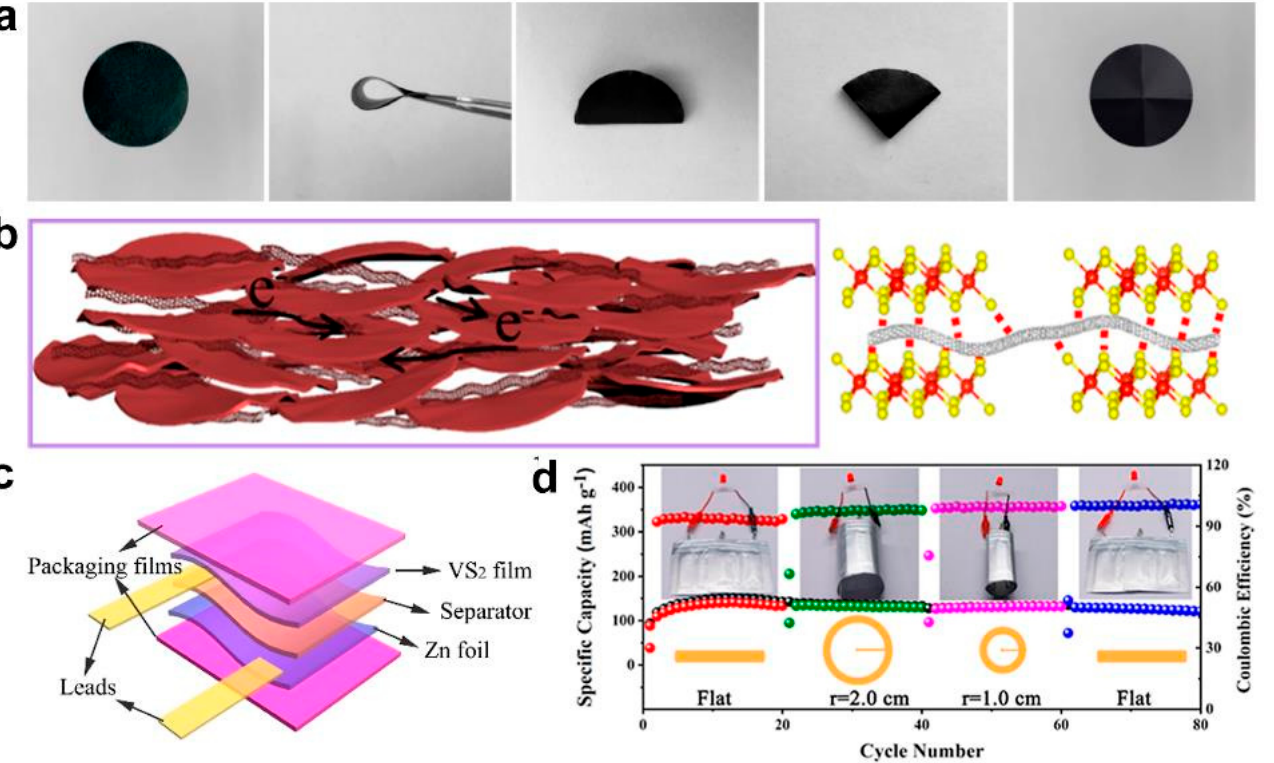
Figure 4. ( a ) Optical images of the flexible C-VS 2 film [54]. ( b ) Diagram of C-VS 2 composite achieving C-V chemical bond independence [54]. ( c ) Soft-packaged Zn//C-VS 2 battery schematic diagram [54]. ( d ) Cycle performance of flexible packaging battery in different bending states (0.5 A g − 1 ) and LED screen lighting in different bending states [54].